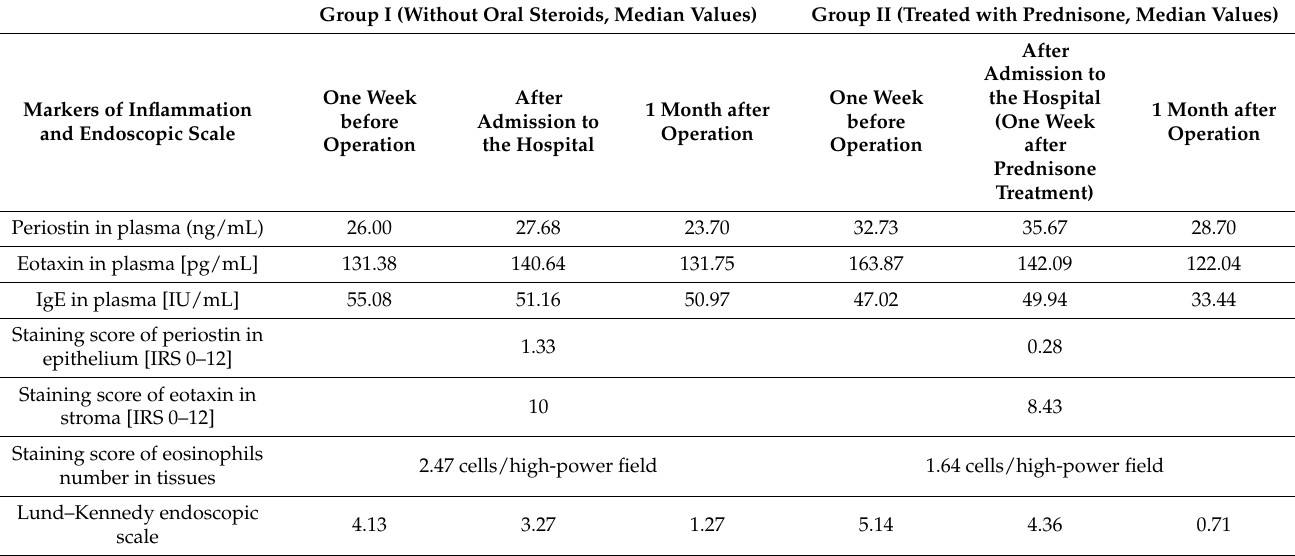
Figure 3. Medium periostin level in epithelium in groups 1 and 2. This was correlated with better healing after surgery, mostly shown by lower scores in the Lund–Kennedy endoscopic scale (Table 1). By performing an endoscopic examination of both nasal cavities separately, we assessed the presence and intensity of edema, polyps and secretions in the nasal meatus using the Lund–Kennedy scale. We obtained a score in the range of 0–12 points. In patients treated with prednisone, we observed less crusting, edema and polyp formation. Table 1. Median values of inflammation markers and endoscopic scale in groups I and